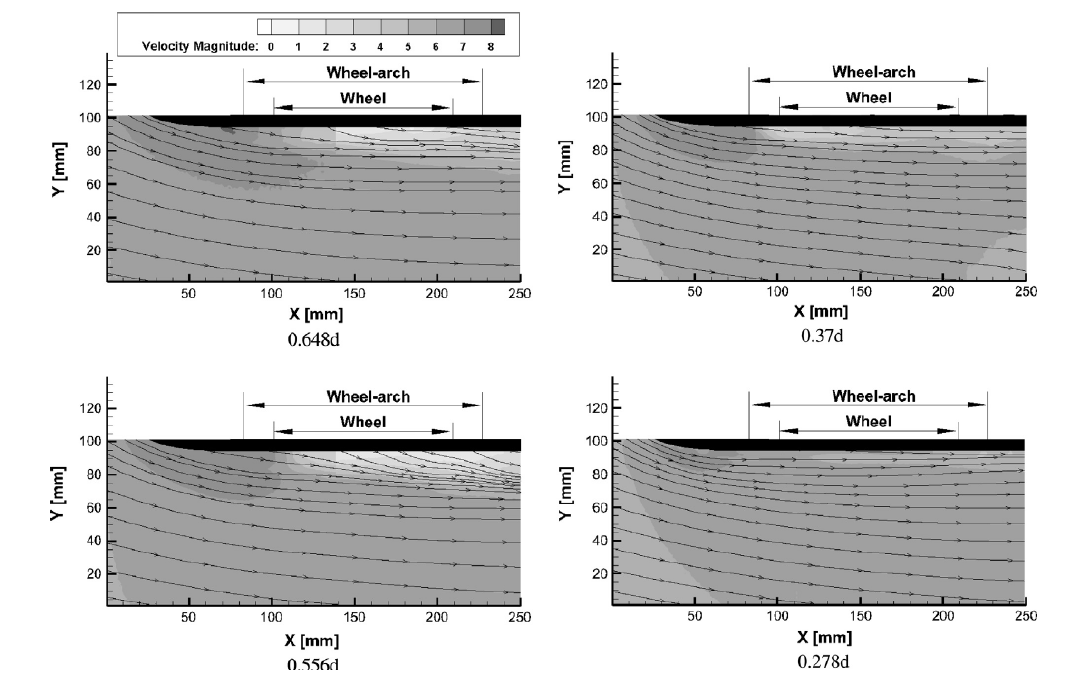
Figure 10. Horizontal plane streamlines with contours of velocity magnitude. Planes are measured from the centre of the wheel